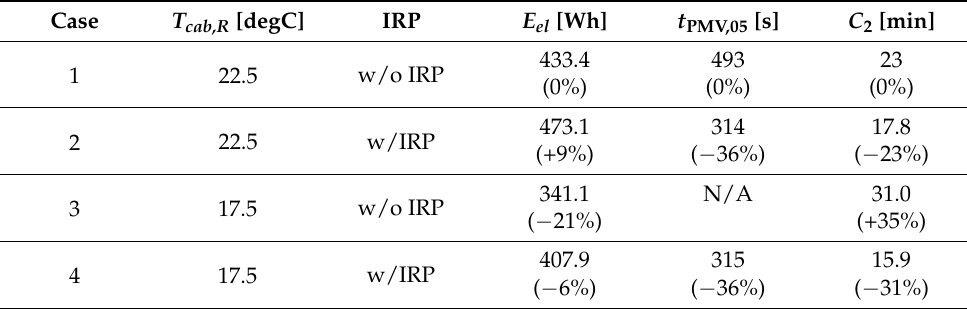
Table 3. HVAC system performance indices obtained from heat-up scenario simulation